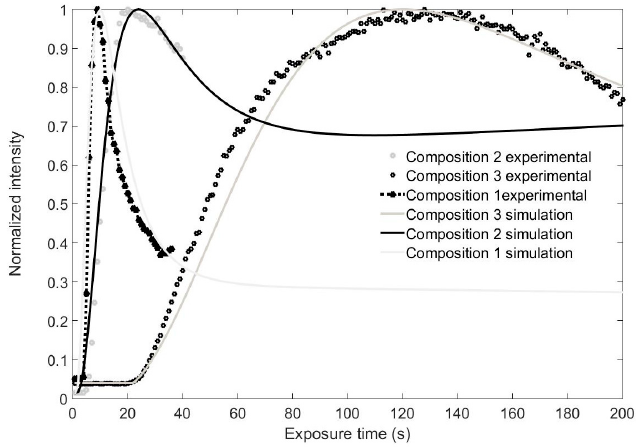
Figure 5. Normalized intensity as a function of recording time at the focal point for different material compositions: experiments and simulations. Focal length of 13 cm.